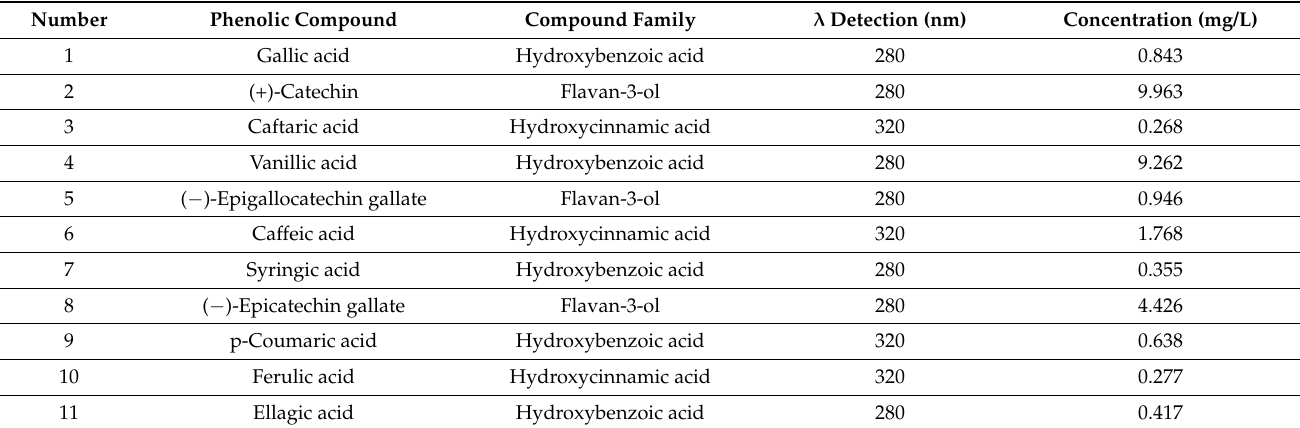
Table 1. Flavonoid compounds detected in HAE, their compound families, exact concentrations and detection wavelengths.